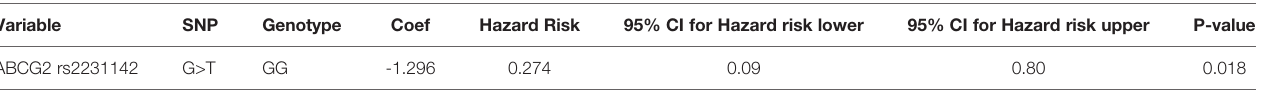
TABLE 5 | Cox regression model for SNPs and lost of MR3.